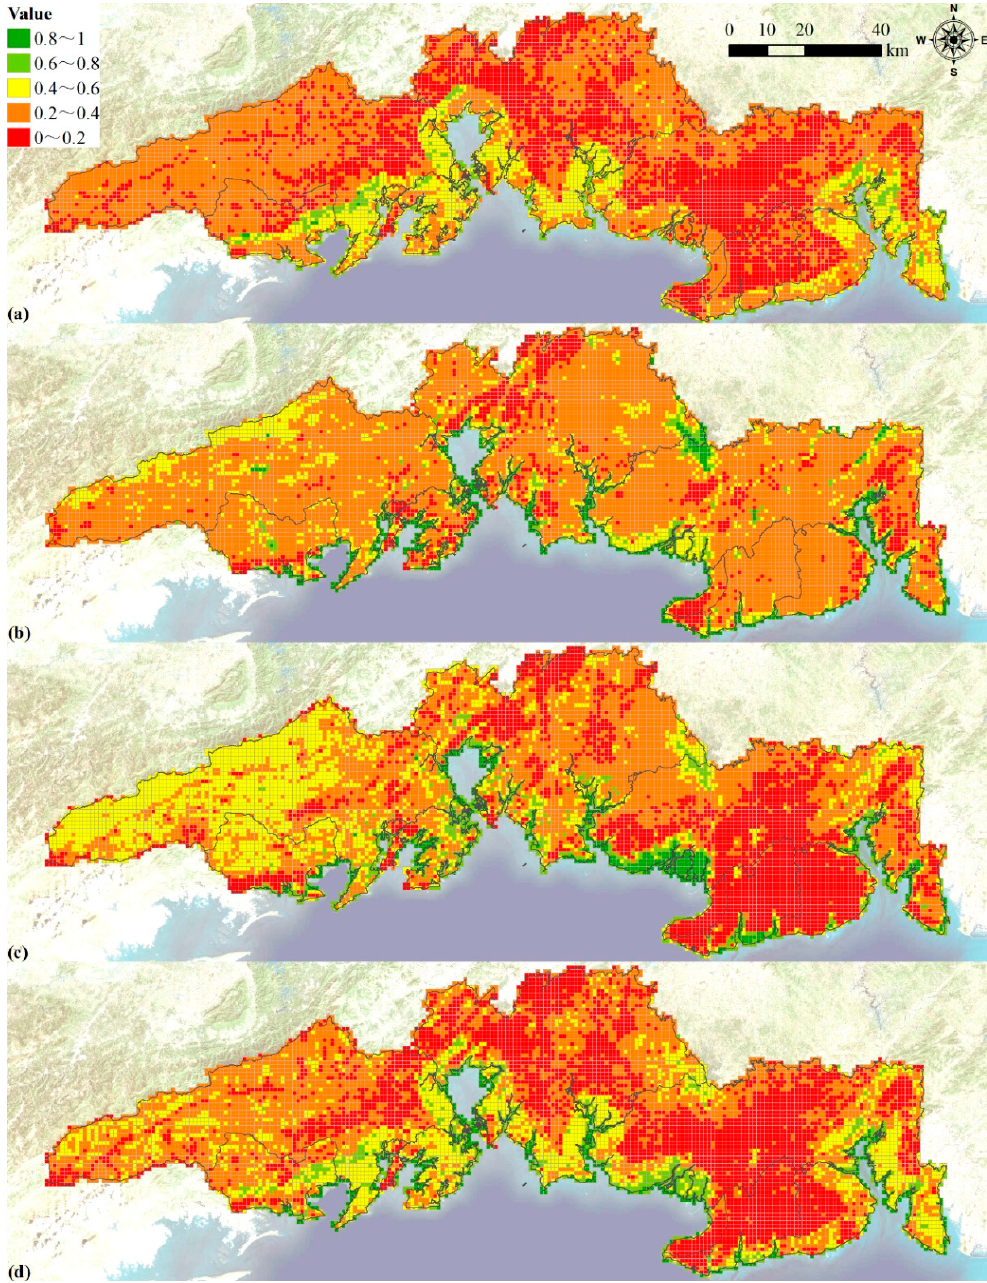
Figure 5. Assessing results for land resources ( a ), water resources ( b ), ecological conditions ( c ) and comprehensive carrying capacity ( d ) in the study area with 1 km grid.